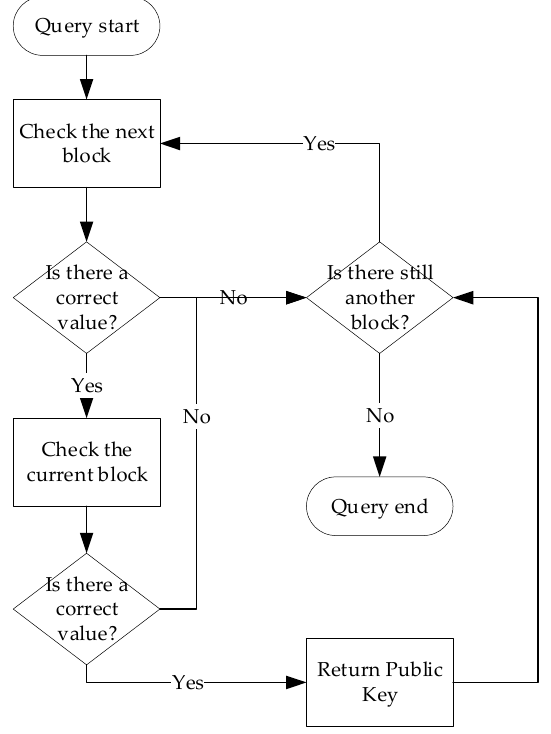
Figure 7. The Data in the blockchain query process.